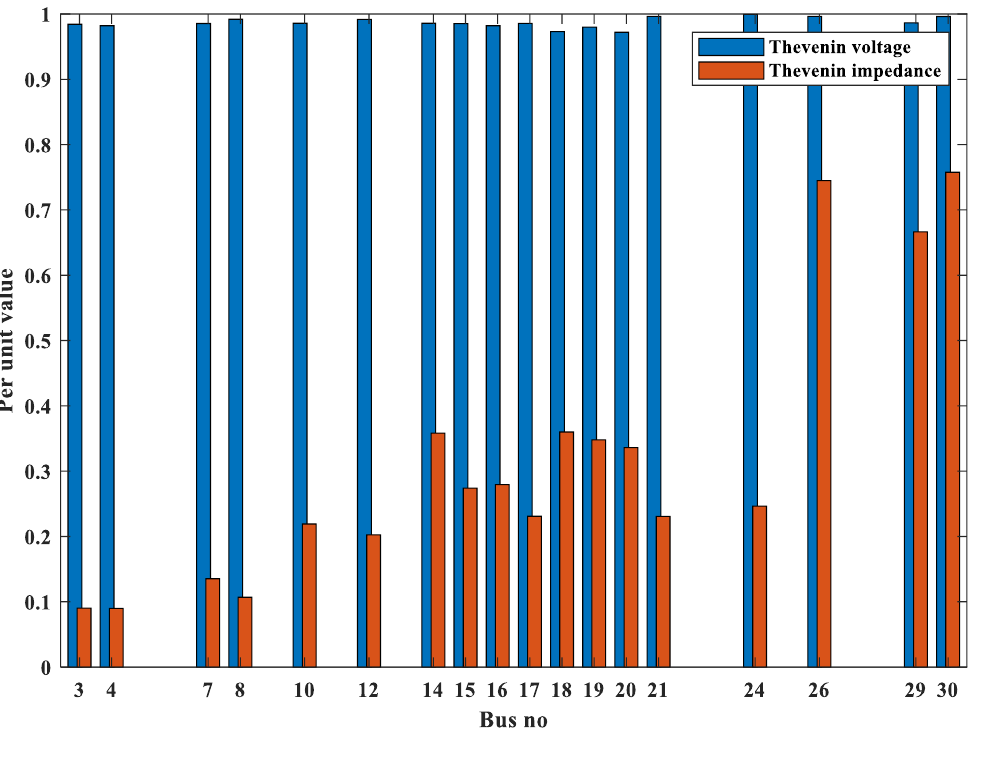
Figure 4 . Thevenin equivalent parameters seen by the load buses of IEEE 30 bus